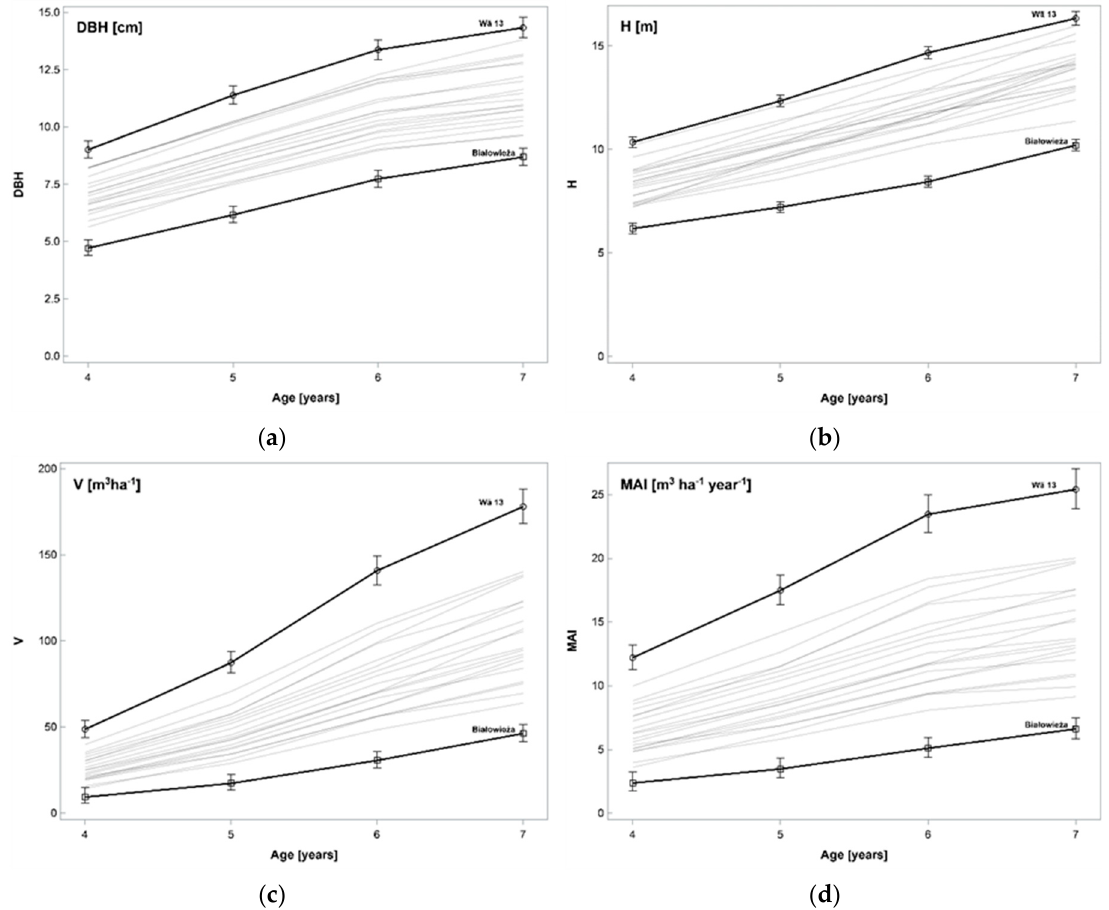
Figure 2. Trend lines of ( a ) mean diameter at breast height (DBH), ( b ) height (H), ( c ) stem volume (V) and ( d ) mean annual increment (MAI)) for clones over time. The bold line with square symbols indicates a trend for a mixture of 30 clones of P. tremula L. (TA) plus trees from wild populations in the Białowie˙za Forest (Białowie˙za = reference), and the bold line with circle symbols for the best performing clone. Vertical bars denote standard errors.